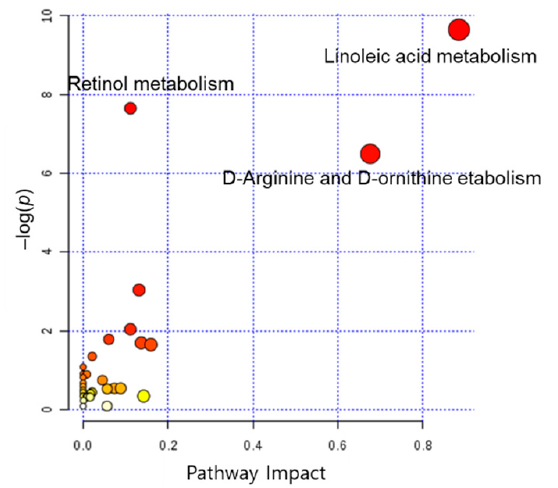
Figure 3. Scatter plot of pathway impact analysis. y -axis represents p value.